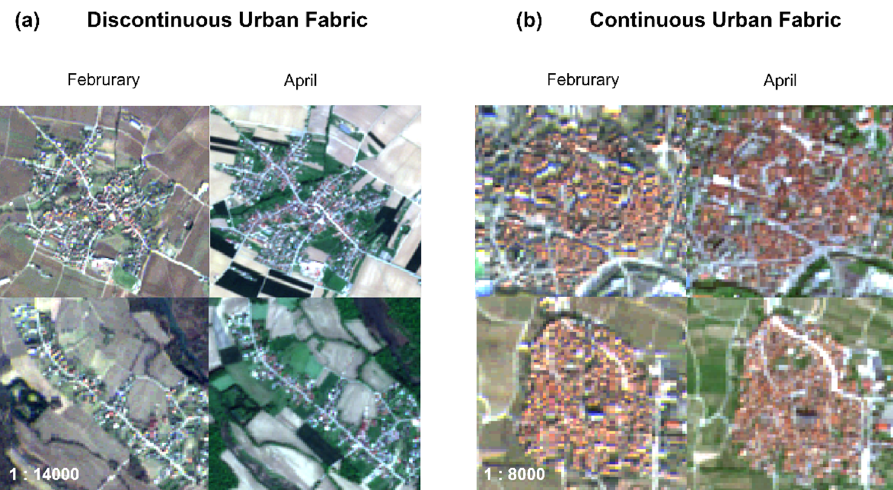
Figure 1. The temporal variation of two classes of urban fabric from winter to spring. ( a ) Discontinuous urban fabric shows important changes mainly due to the presence of vegetation; ( b ) continuous urban fabric remains almost the same from winter to spring due to the presence of buildings and the scarcity of vegetation.